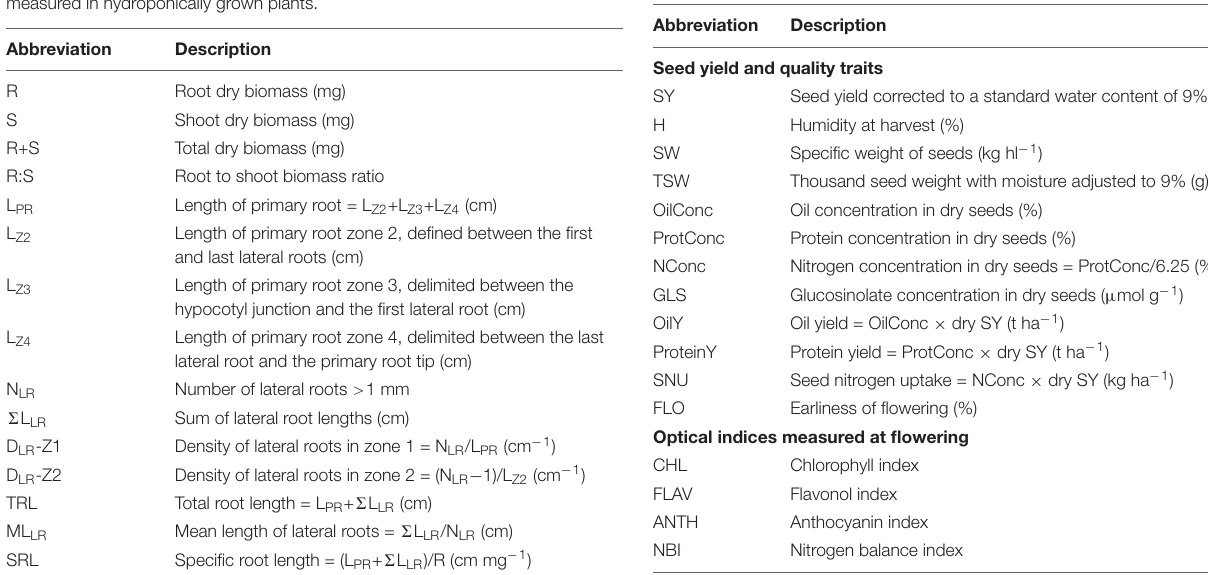
TABLE 2 | Definition of field